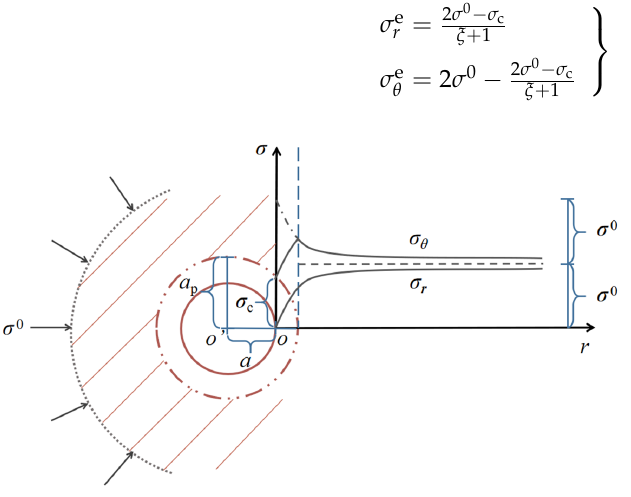
Figure 2. Elastoplastic stress distribution for the surrounding rock of the deep tunnel cross section.